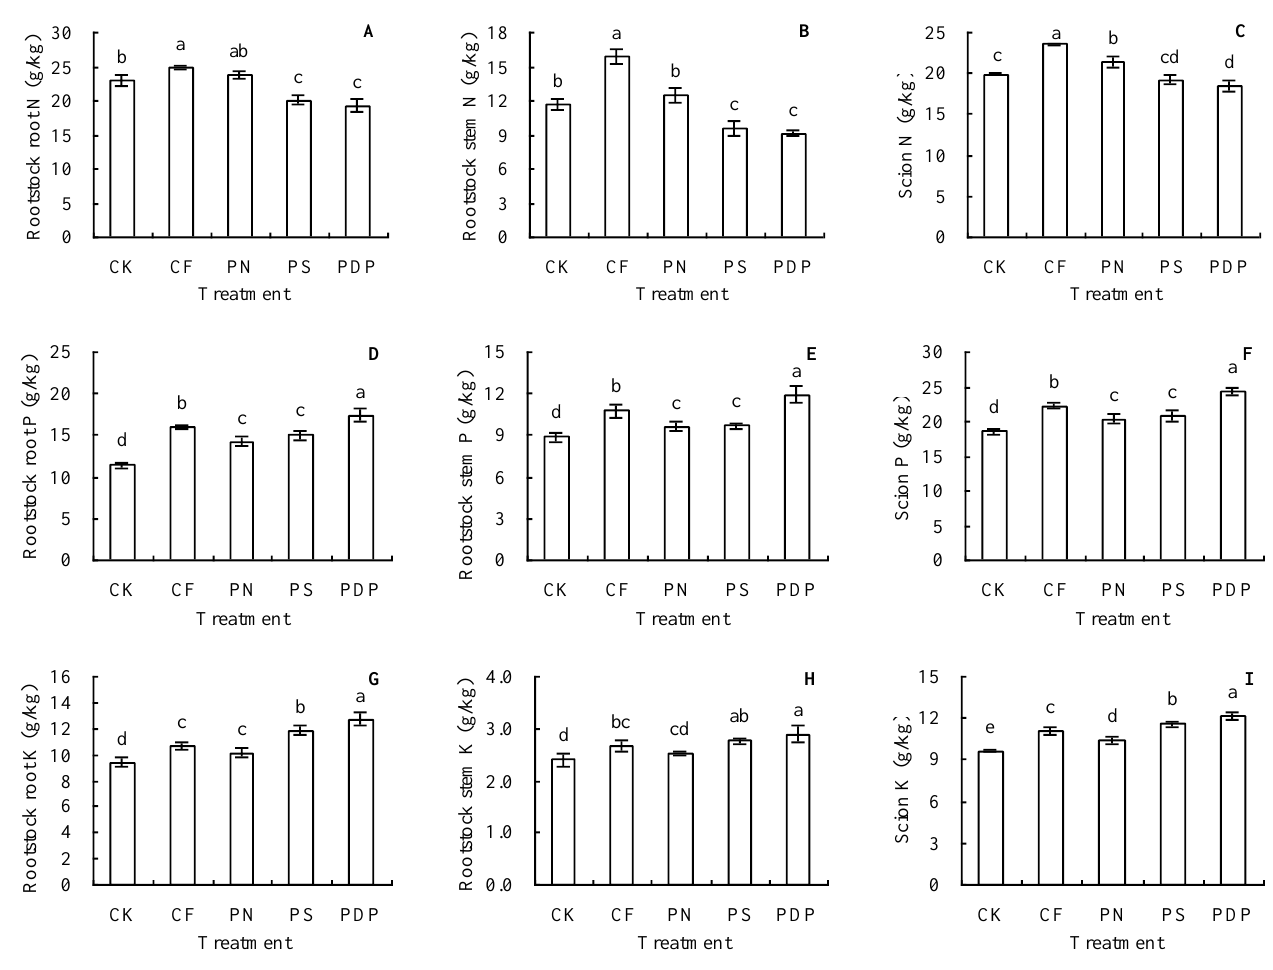
Figure 2. Total nutrient (N, P, and K) contents in grapevine plants. ( A ) Rootstock root total N content; ( B ) rootstock stem total N content; ( C ) scion total N content; ( D ) rootstock root total P content; ( E ) rootstock stem total P content; ( F ) scion total P content; ( G ) rootstock root total K content; ( H ) rootstock stem total K content; ( I ) scion total K content. Different lowercase letters indicate significant differences among the treatments (Duncan’s Multiple Range Test, p < 0.05). CK—control; CF—complex fertilizer; PN—potassium nitrate; PS—potassium sulfate; PDP—potassium dihydrogen phosphate.